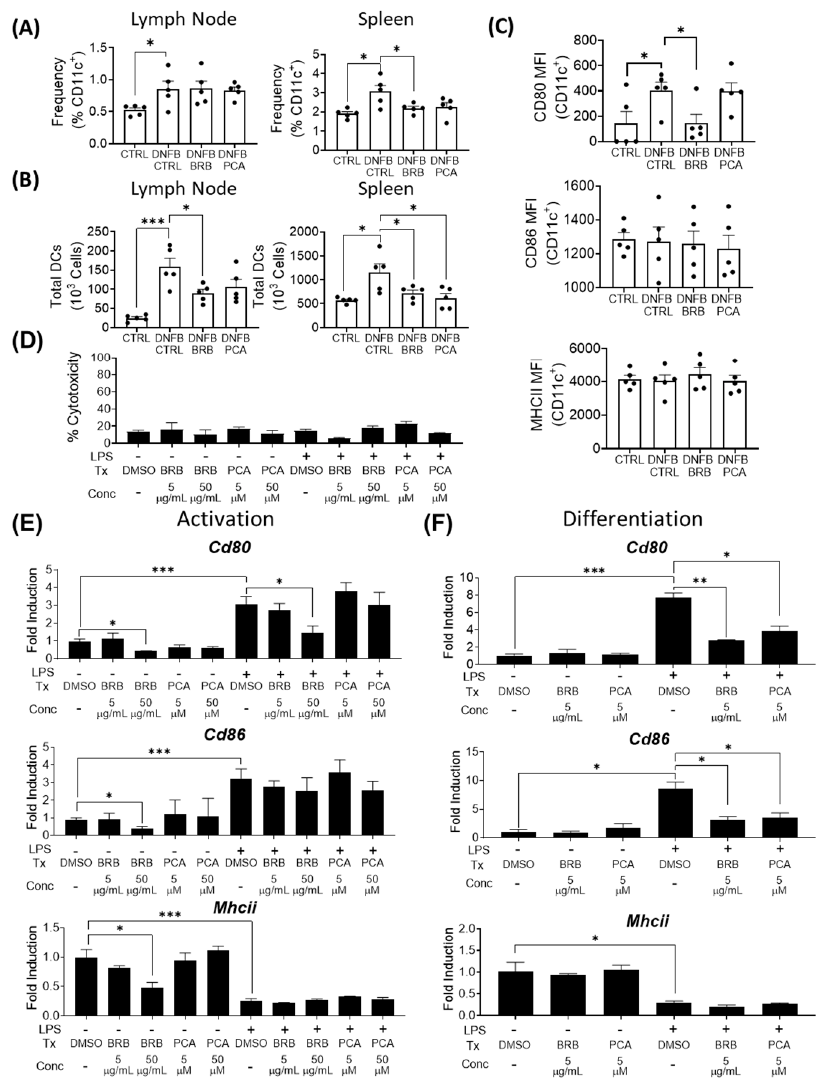
Figure 2. E ff ects of BRB and PCA on dendritic cell migration, maturation and antigen presentation during DNFB induced CHS ( A ) CD11c + dendritic cell population frequencies among total live cells within the draining lymph nodes and spleens of experimental mice determined by flow cytometry. ( B ) Total dendritic cell counts within the spleens and lymph nodes measured as the product of CD11c + dendritic cell population frequencies and hemocytometer-derived cell counts of whole organ single cell suspensions. ( C ) Mean fluorescent intensity (MFI) of CD80, CD86, and MHCII expression by splenic CD11c + dendritic cells. ( D ) Percent cytotoxicity, relative to a wholly lysed equivalent sample, by experimental concentrations of DMSO, BRB-E, and PCA, measured by an LDH cytotoxicity assay. ( E , F ) Expression of Cd80 , Cd86 , and Mhcii by ( E ) activation study and ( F ) di ff erentiation study dendritic cells determined by RTqPCR. * p -value < 0.05; ** p -value < 0.01; *** p -value < 0.005 for comparisons between DNFB-challenged mice fed control diet and comparison groups using Student’s t test, and for comparisons between DMSO control samples and comparison groups.